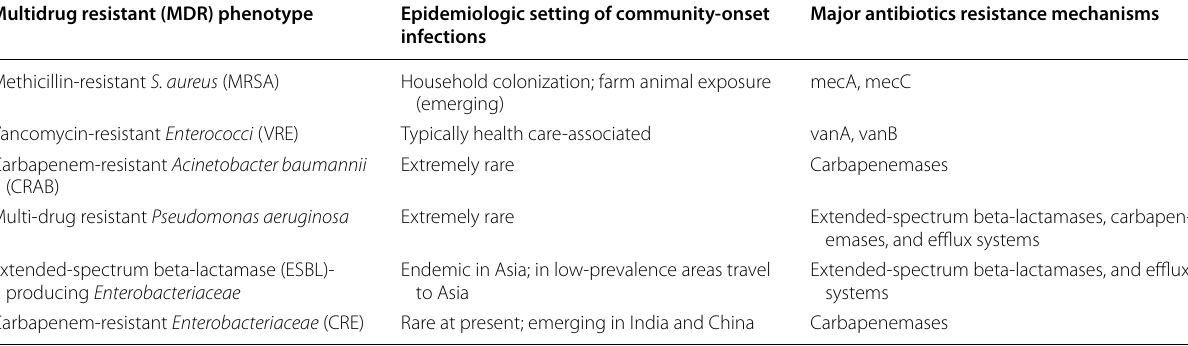
Table 1 Multidrug resistant bacteria observed in the community (Duin and Paterson 2016) Multidrug resistant (MDR) phenotype Epidemiologic setting of community-onset infections